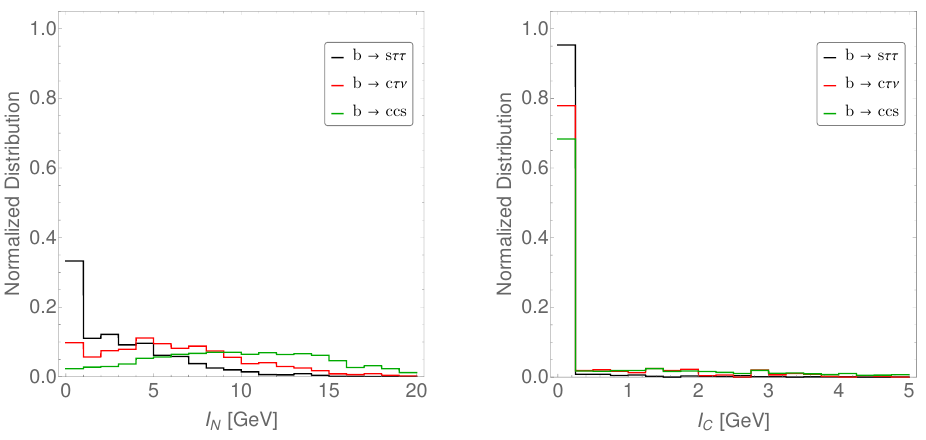
Figure 3 . Distributions of I N (left) and I C (right) for the B 0 → K ∗ 0 τ + τ − measurement. Here I N and I C denote the overall isolation of the reconstructed τ leptons and K ∗ 0 meson in each event, from the other neural particles and displaced tracks, respectively.